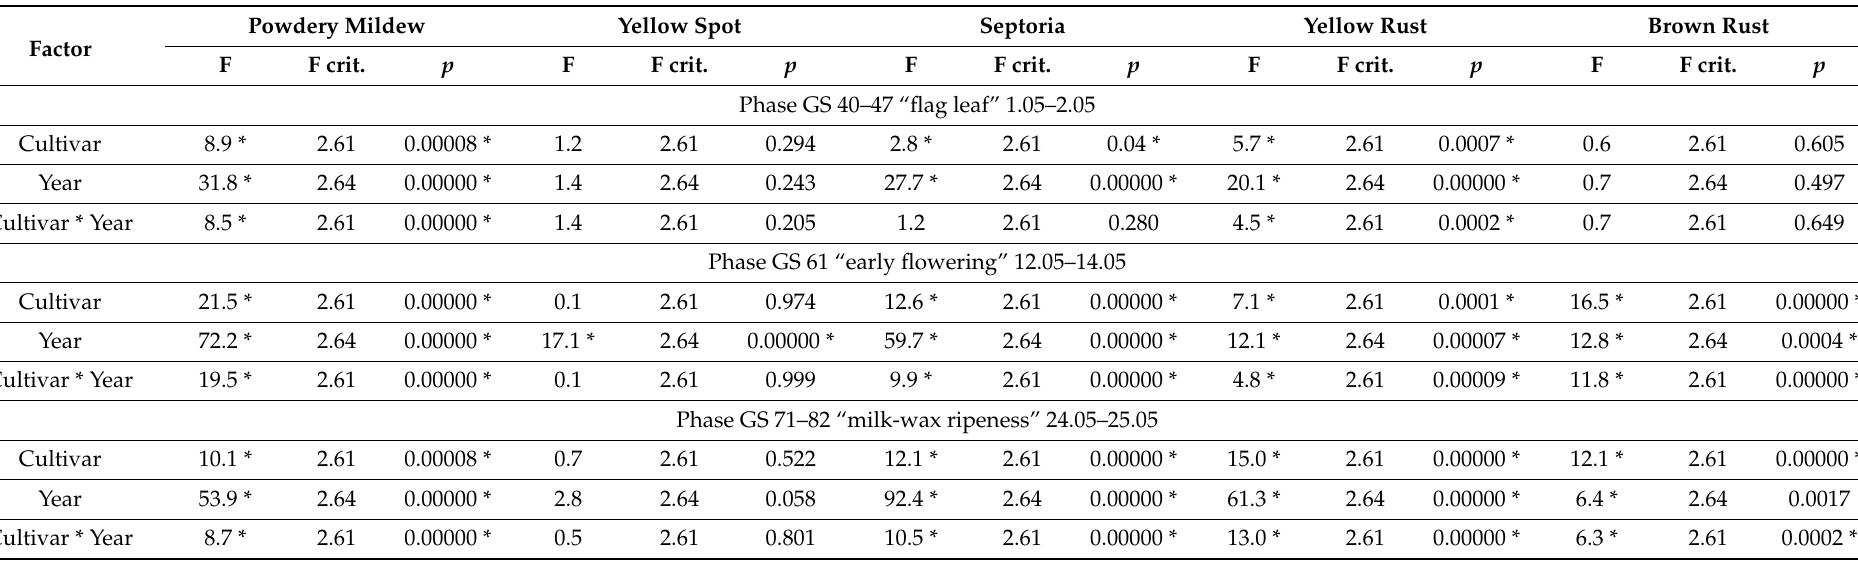
Table 2. Assessment of the influence of the factors cultivar and year on the development of winter wheat pathogens for three growing seasons from 2019 to 2021. Powdery Mildew Yellow Spot Septoria Yellow Rust Brown Rust Factor F F crit. p F F crit.